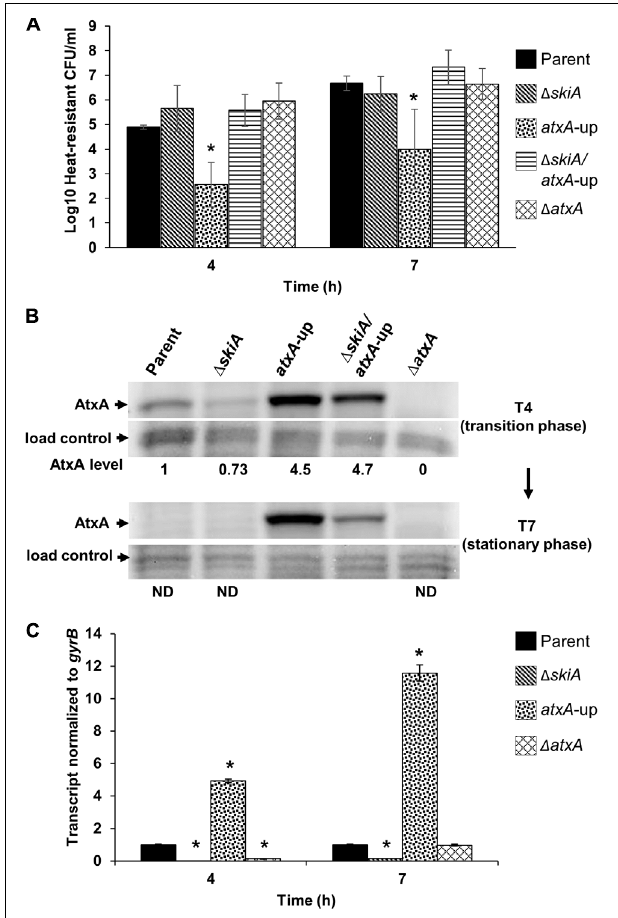
FIGURE 3 | Spore quantitation, AtxA protein abundance, and skiA transcript levels in PA-air. (A) Heat-resistant CFU/ml of parent and mutant derivatives. (B) AtxA protein levels in parent and mutant strain backgrounds. Culture samples were obtained during transition (T4) and stationary (T7) phases of growth, and subjected to Western blot analysis using rabbit α -AtxA antibody. Protein loads were determined based on OD 600 values and normalized to cross-reactive products from α -AtxA or α -RNAP- β blots. These data are representative of three separate experiments. Non-detectable (ND) levels of AtxA are denoted. (C) RT-qPCR of skiA transcripts at 4 and 7 h, respectively, normalized to the parent control. These data represent average values of detectable transcripts from three independent cultures. Asterisks denote p -values ≤ 0.05 relative to